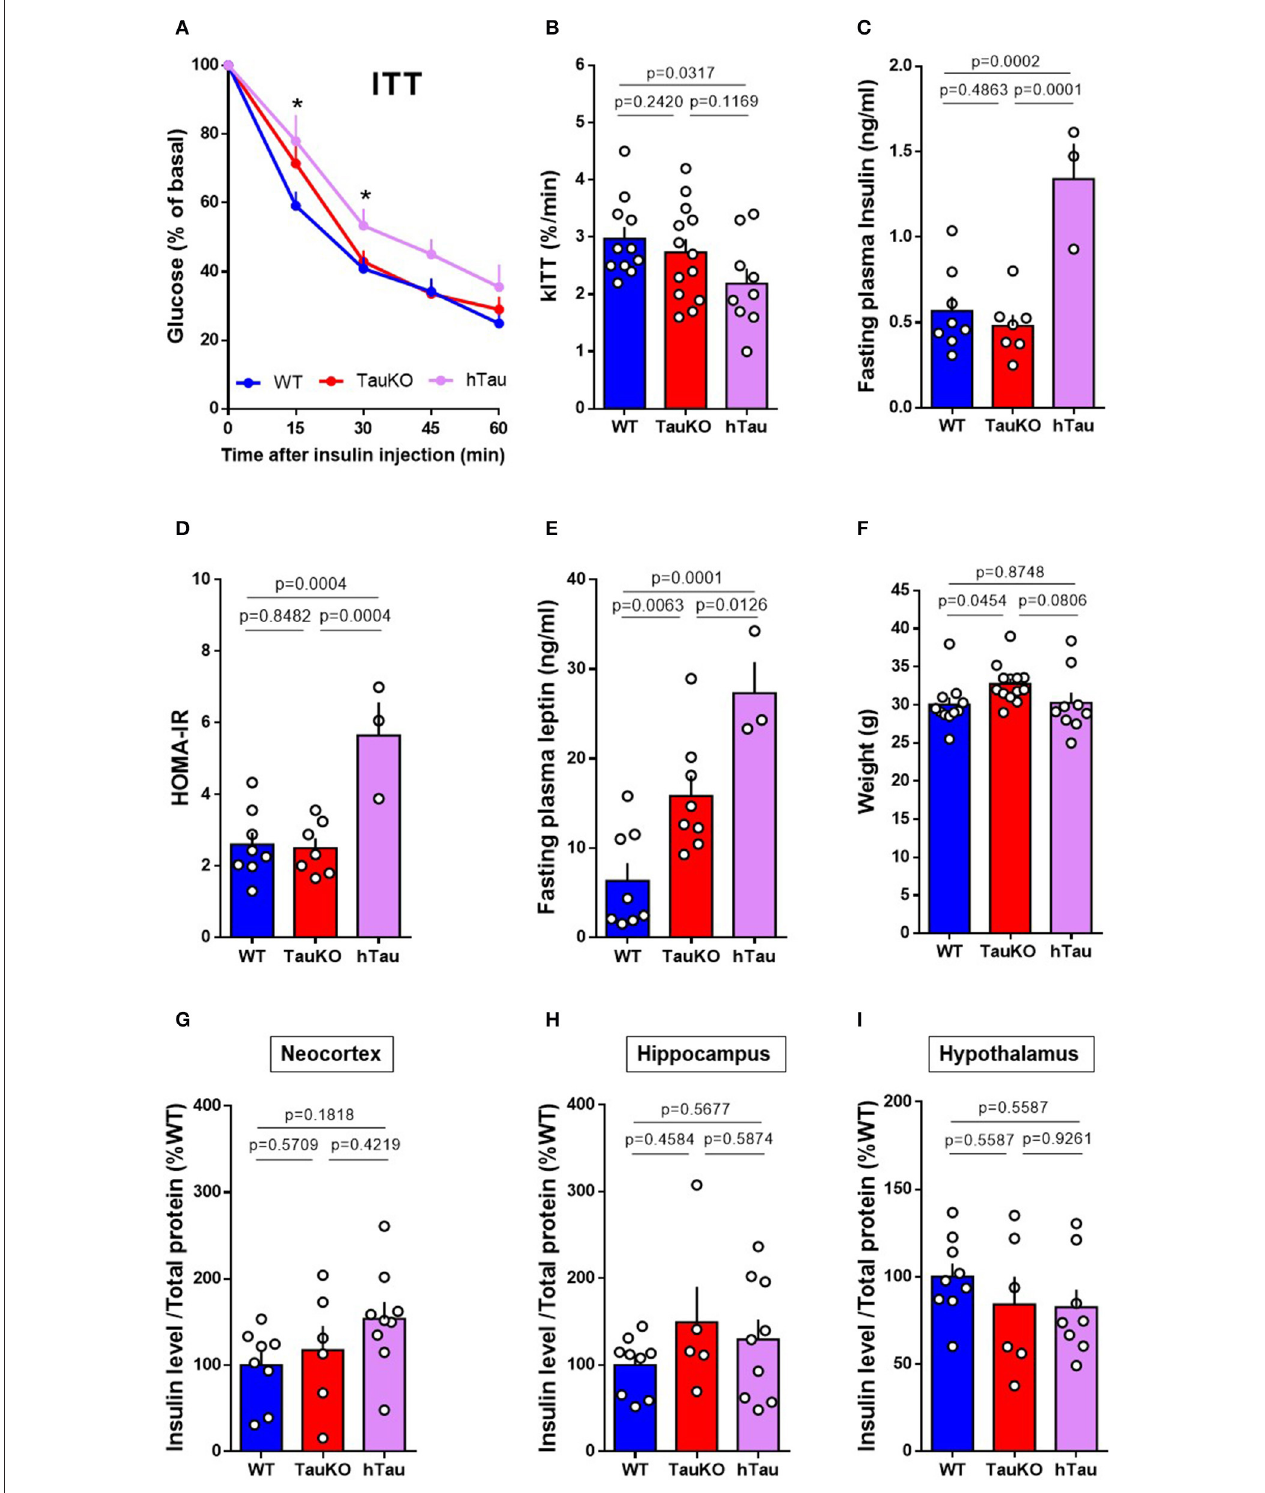
FIGURE 1 | Peripheral insulin sensitivity and brain insulin levels of TauKO and hTau mice. (A) Insulin Tolerance Test (ITT) with 20 weeks old WT, TauKO, or hTau mice. After 4h fasting, mice received 1U/kg of intraperitoneal insulin and blood glucose levels were measured at the designated time points from tail vein blood ( n = 11 WT; 13 TauKO; 9 hTau). (B) Bar graphs representing the kinetic constants for glucose disappearance (Kitt) calculated from the time course plot ( n = 11 WT; 13 TauKO; 9 hTau). (C) Plasma insulin levels after fasting measured by ELISA ( n = 8 WT; 7 TauKO; 3 hTau). (D) HOMA-IR calculated from glucose (mMol/L) and insulin